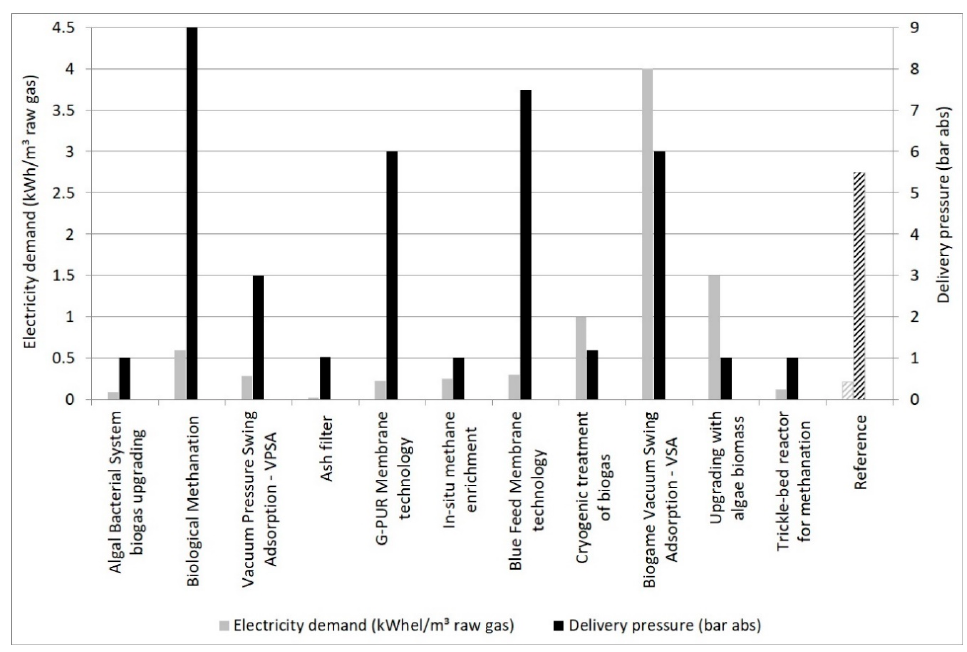
Figure 4. Electricity demand and delivery pressure for upgrading technologies.